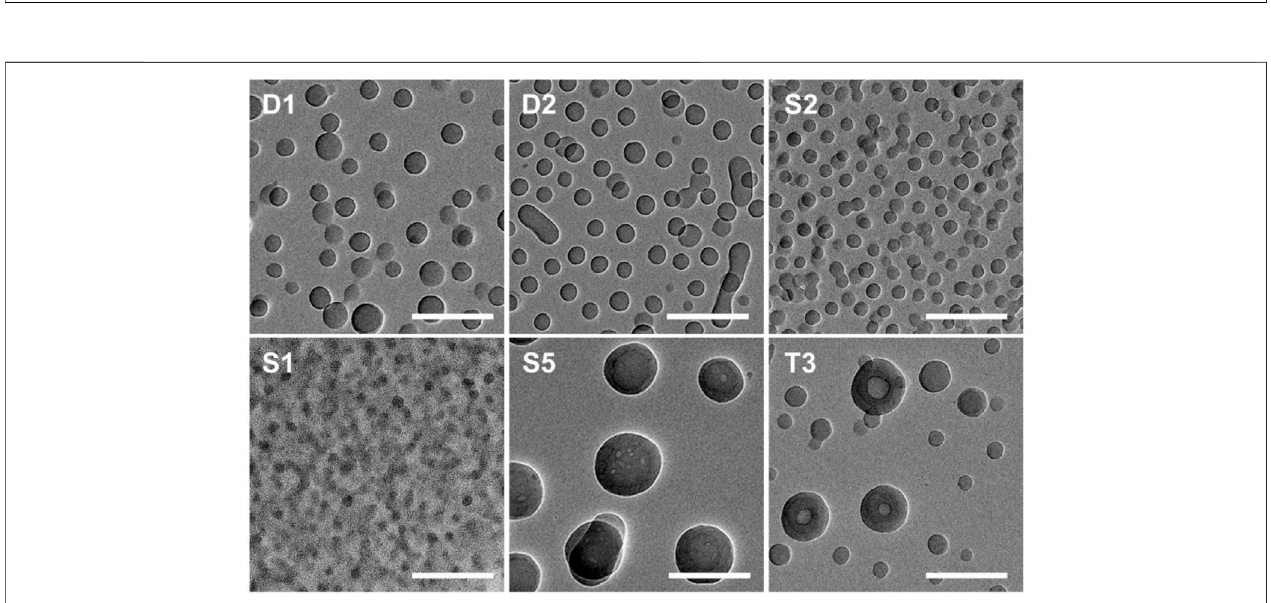
FIGURE2| TEMimagesofBCPNPscastfromapolymermethanol/THF(v:v=3:1)solutionat C =.25 mg/ml.Eachscalebaris200 nm.TheIDsinsetineachimage correspond to the sample IDs given in Table 1 .